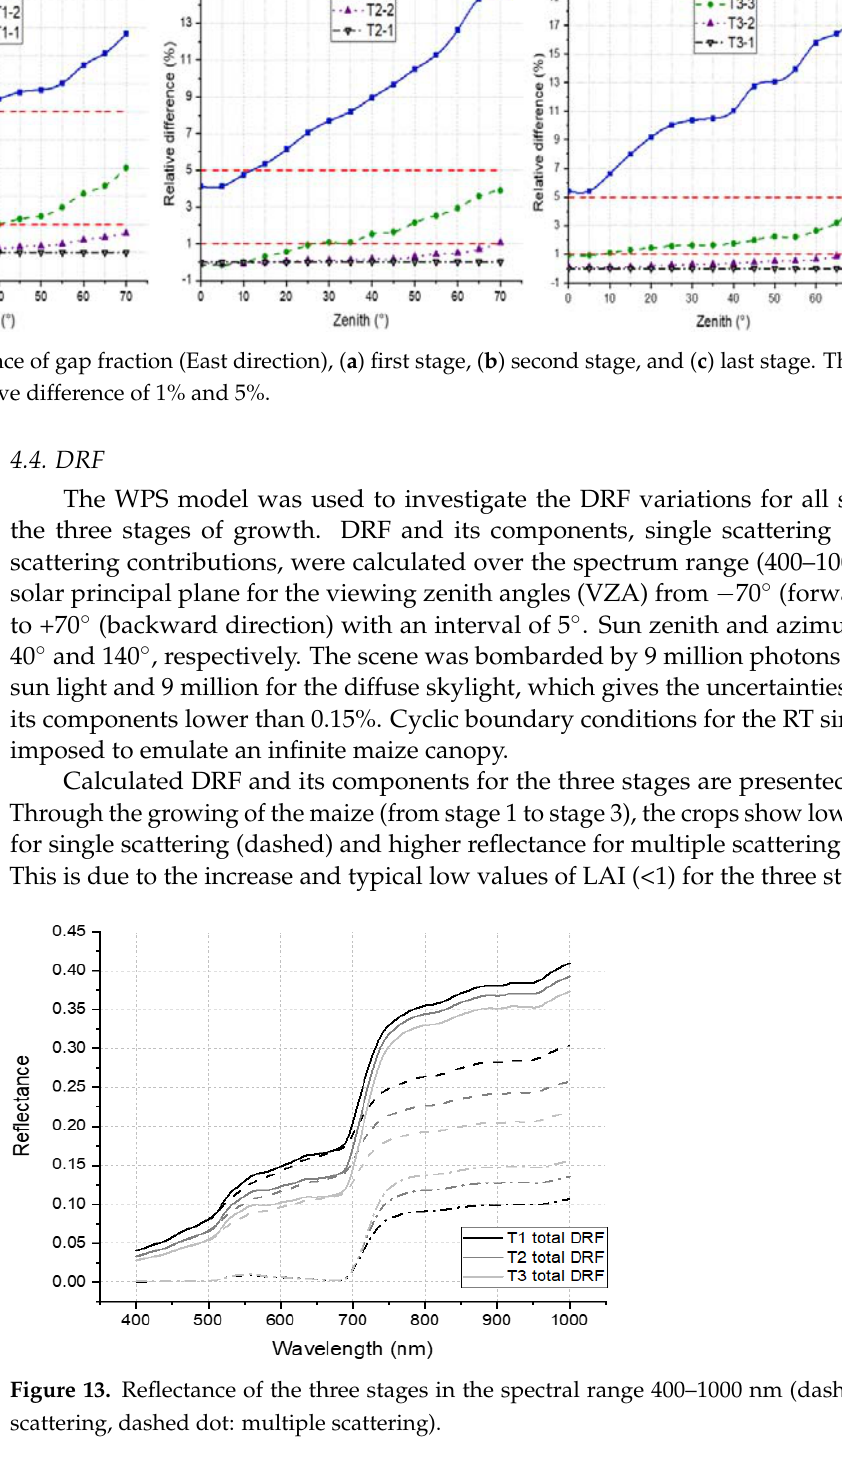
Figure 11. Relative difference of gap fraction (North direction), ( a ) first stage, ( b ) second stage, and ( c ) last stage. The dashed lines in red show the relative difference of 1% and 5%.